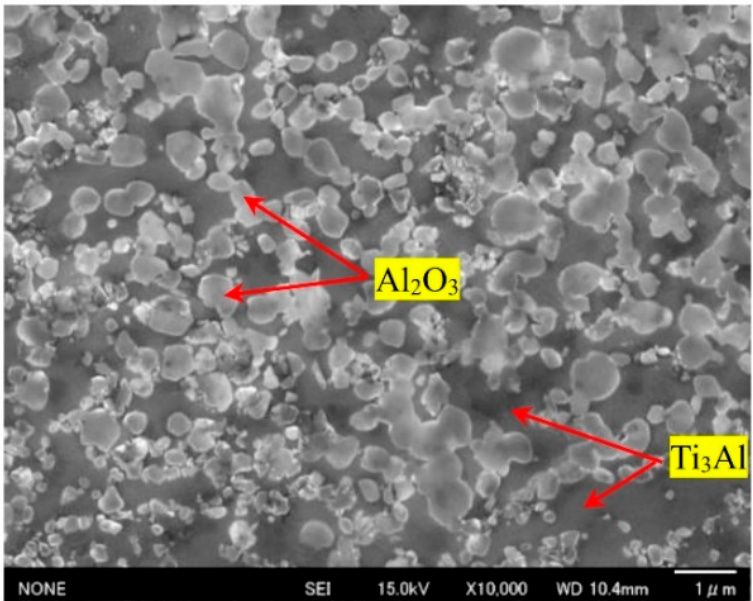
Figure 4. SEM image of Al 2 O 3 /Ti 3 Al composite after 8 h of milling and sintering at 850 °C.